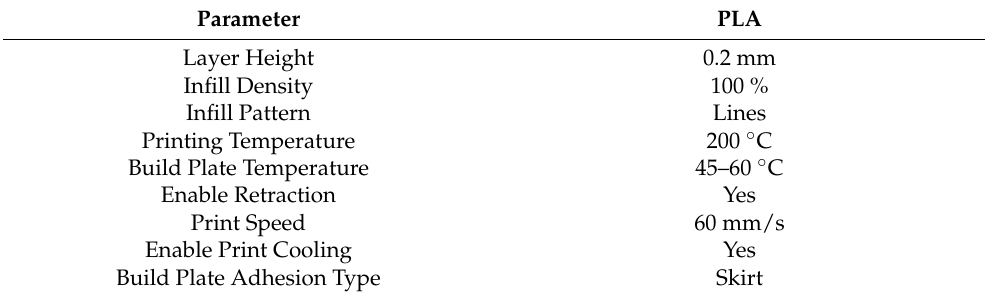
Table 2. Configuration of the printing parameters with PLA in Ultimaker Cura© (version 4.1.0) used for the MG